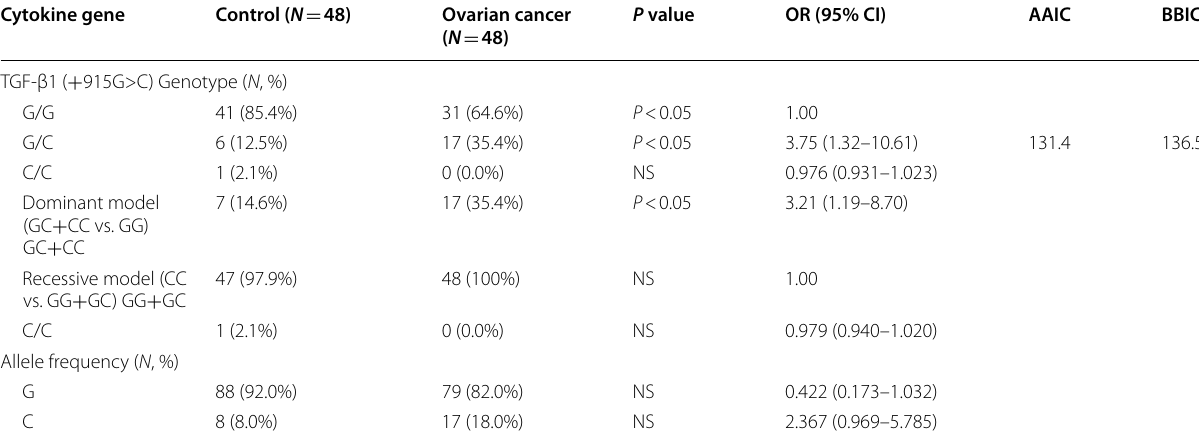
915G>C) in controls and patients with ovarian cancer +